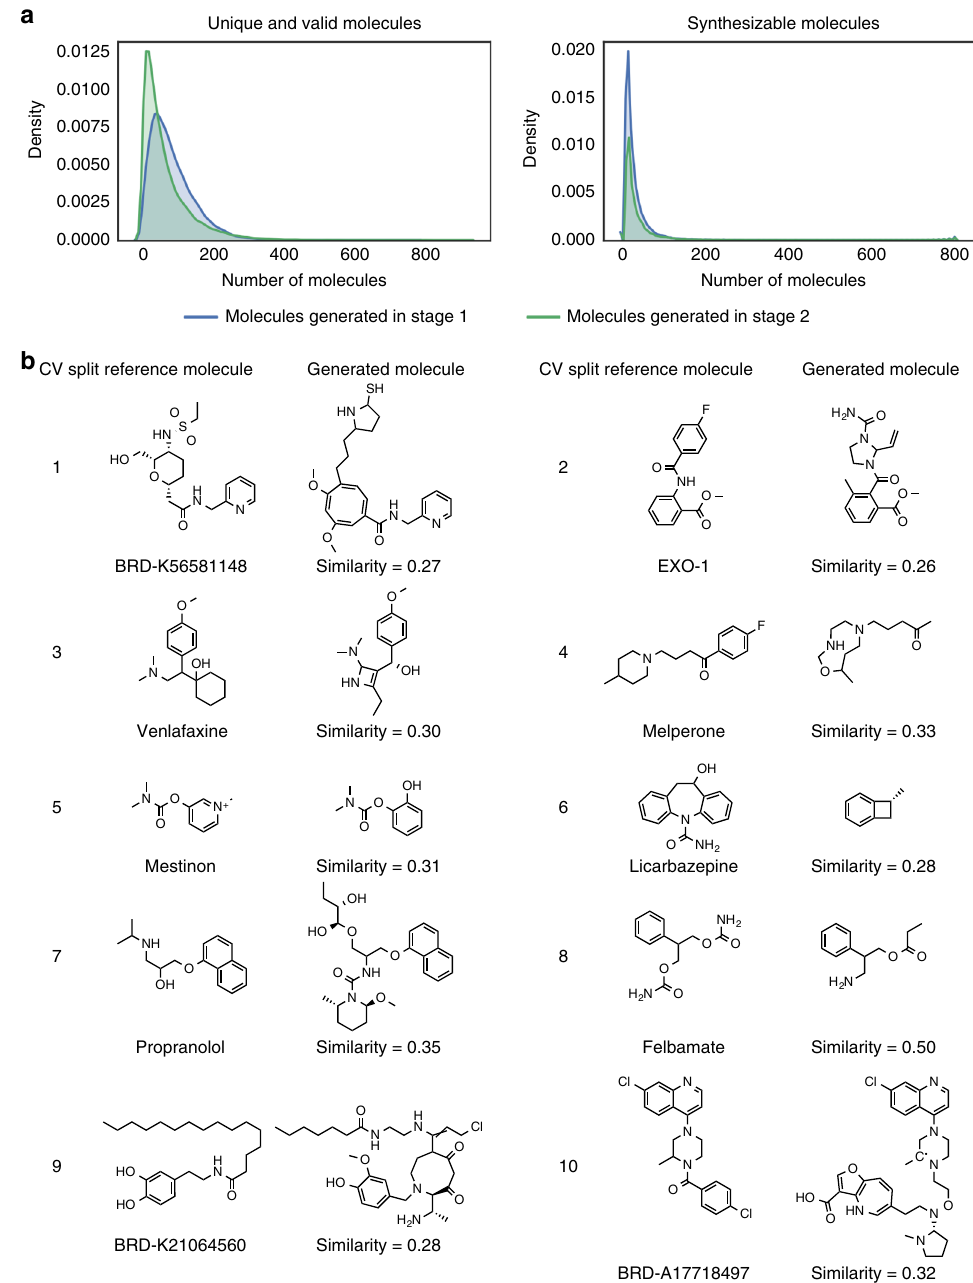
Fig. 2 Examples of generated molecules using a compound-induced gene expression signature. a Distribution of number of valid and synthesizable molecules generated for each of the 31,821 gene expression signatures used in the 10-fold cross validation scheme. Results of Stage I are shown in blue and for Stage II in green. b Examples of generated molecules with their reference compound obtained for each cross-validation split and their respective Tanimoto similarity using Morgan fi